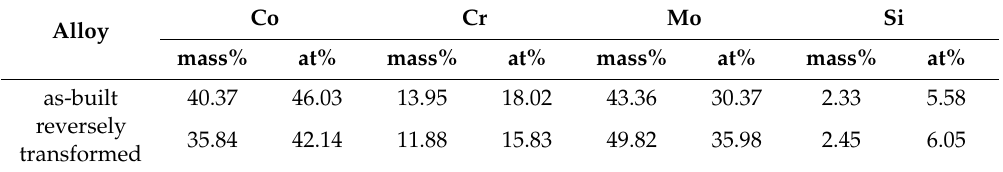
Table 2. Chemical compositions of Co 3 Mo 2 Si-type precipitates observed in the low-C as-built and reverse treated alloys (analyzed by transmission electron microscopy-energy dispersive X-ray spectrometry (TEM-EDX)).